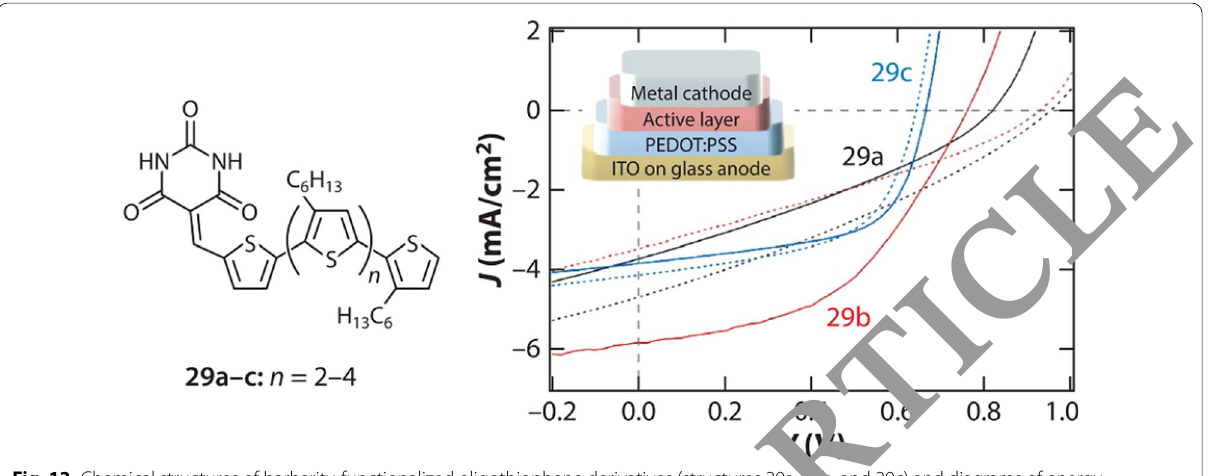
Fig. 13 Chemical structures of barbarity-functionalized oligothiophene derivatives (structures 29a, 29b, and 29c) and diagrams of energy conversion efficiency in annealed thin films of these molecules at 80 °C. Annealing causes molecular self-assembly and the formation of coarse particles forming a conductive gel